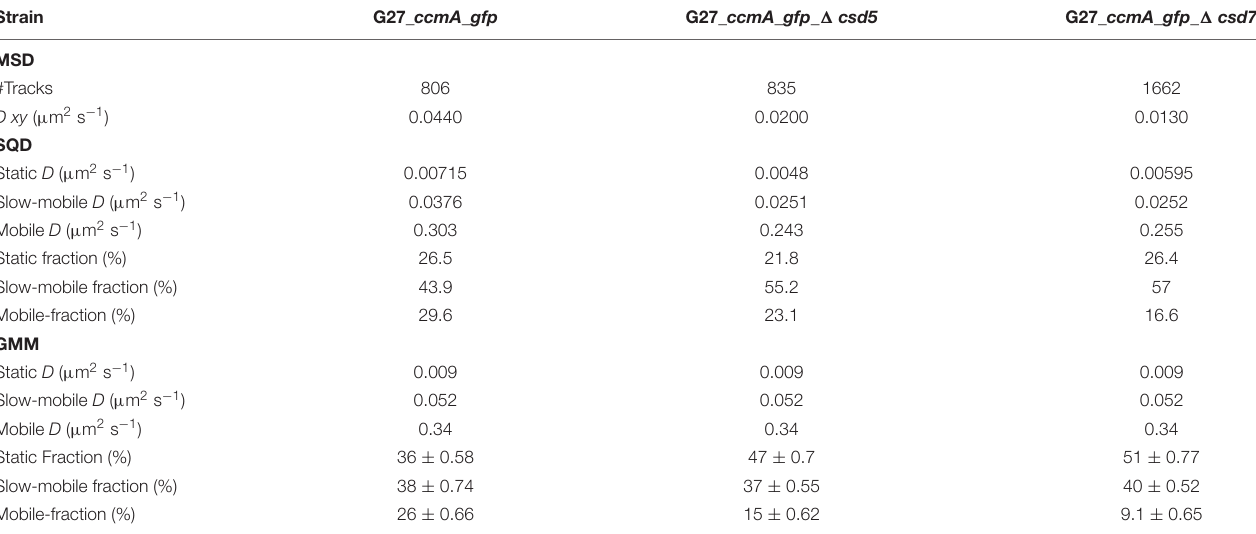
TABLE 1 | Summary of CcmA_Gfp single-molecule